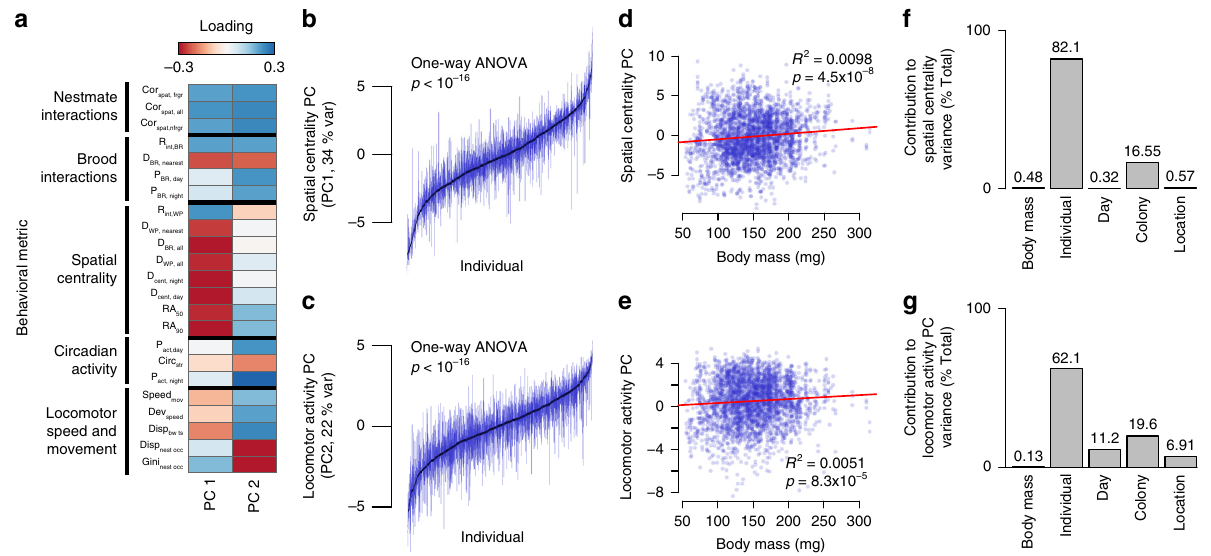
Fig. 4 Bumble bee workers show strong individual variation in nest behavior that is stable across days and not associated with body size. a Loadings of individual behavioral metrics on Principal Components 1 and 2, with color indicating direction and strength of loading. Labels indicate clusters of correlated variables (Supplementary Fig. 3). b,c PC1 ( “ Spatial centrality ” ( b )) and PC2 ( “ Locomotor activity ” ( c )) scores across days for all individuals. Boxplots show the median (black marker) and inter-quartile range (IQR, gray bars) for each worker ’ s score across days, with individuals arranged according to median values. c,d Relationship between body mass and PC1 ( d ) and PC2 ( e ). Transparent fi lled markers show data for individual workers on different days, and R 2 and p values are calculated from a linear regression (red line). f,g Relative contribution of body size (mass, mg), individual, day, colony, and experimental location to variance in PC1 ( f ) and PC2 ( g ) scores in undisturbed colonies. Values represent the relative contribution (% of explained variance) using